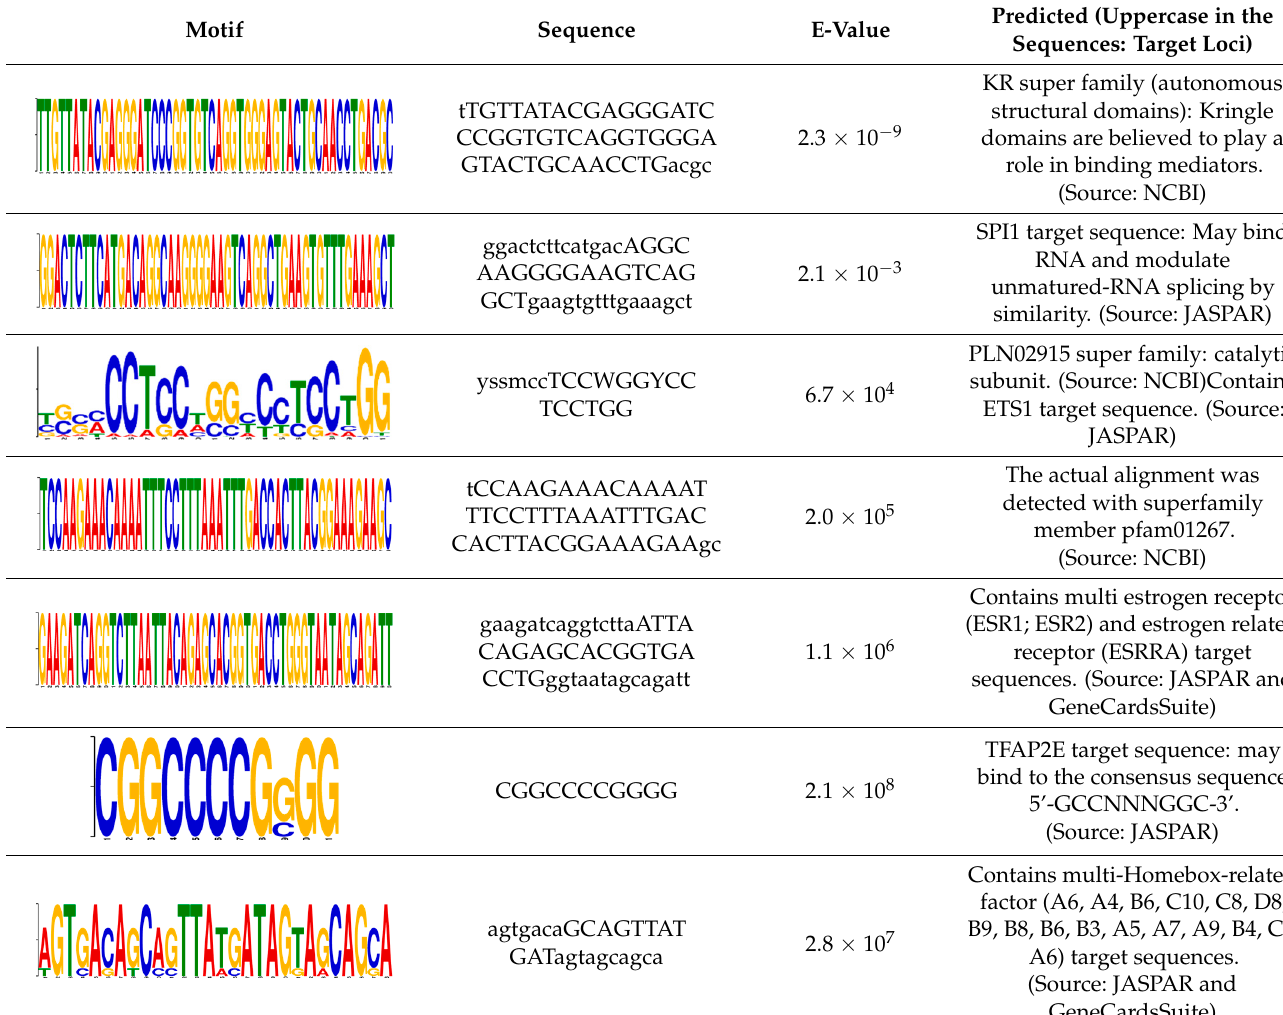
Figure 8. The high attention sequence distribution. ( a ) The length distribution (upper) and the at ‐ tention sequence number for each transcript distribution (lower); ( b ) the extraction of attention se ‐ quence for motif enrichment; ( c ) density distribution of attention loci on all sequences. Table 3. Motif enriched from the sequence.